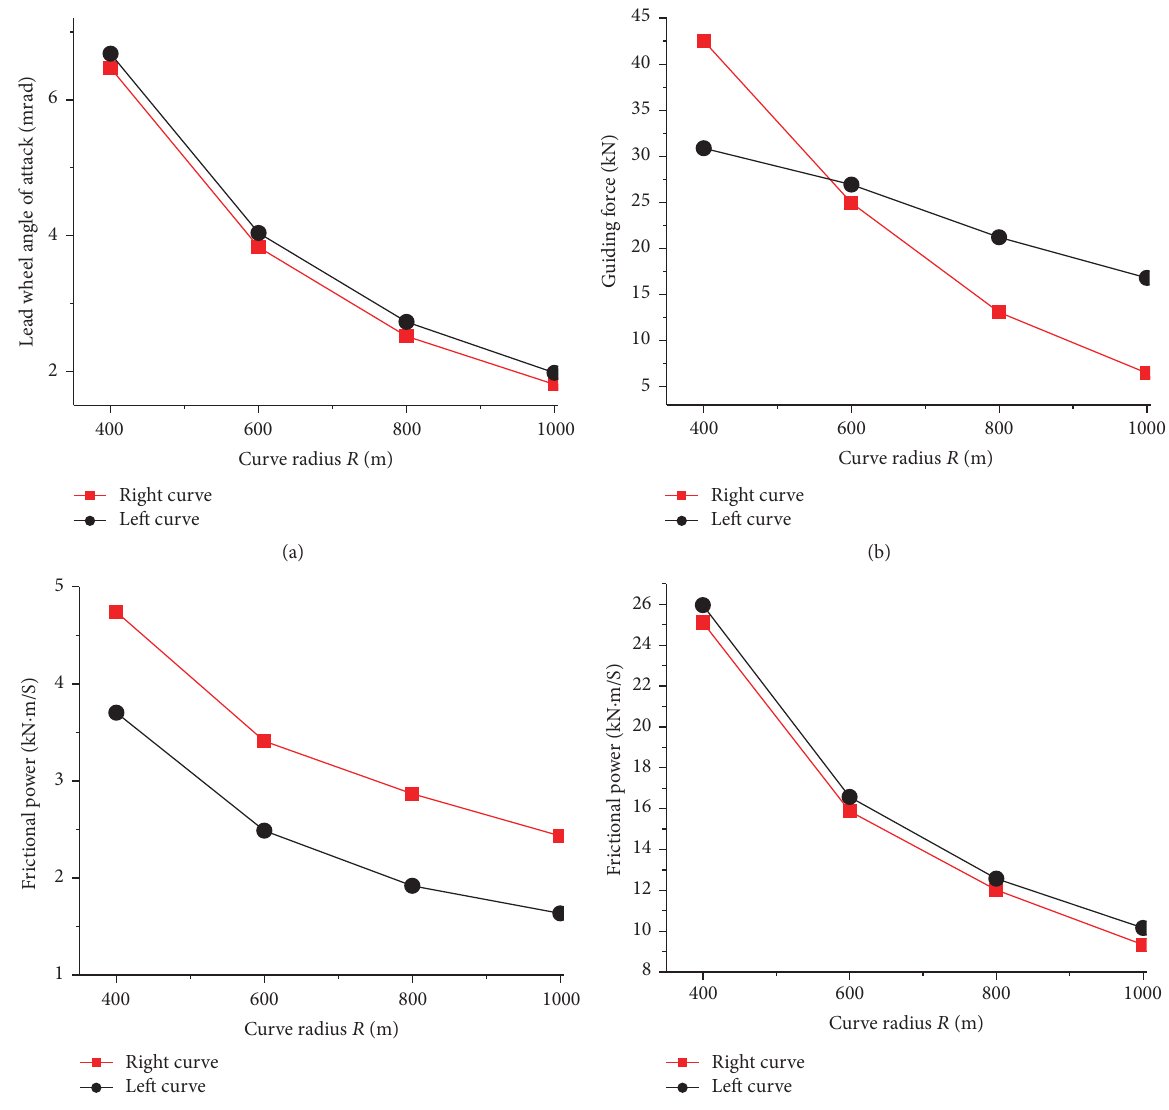
Figure 10: TFDA-bogies symmetry analysis, (a) lead wheel angle of attack, (b) lead wheel lateral force, (c) lead wheel friction power, and (d) total vehicle friction